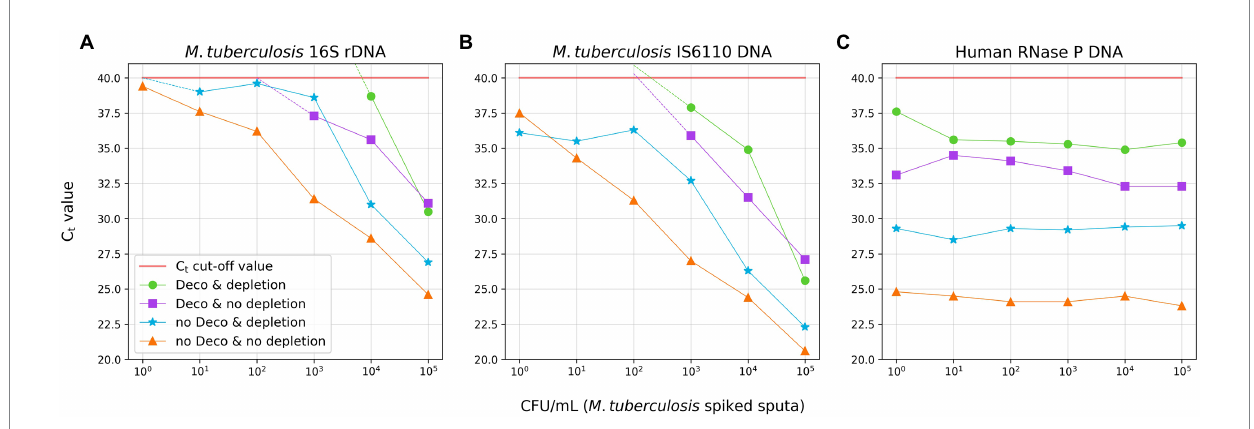
FIGURE 2 DNA yields for decontamination and human DNA depletion experiment. Each plot (A–C) shows real-time PCR C t values following the four possible treatment options involving the application or non-application of decontamination (NALC-NaOH) and depletion (saponin and DNase I). Tests were carried out on sputa spiked with M. tuberculosis at 6 concentrations ranging from 10 0 to 10 5 CFU/mL (colony-forming units/mL). Plot gives the mean of biological